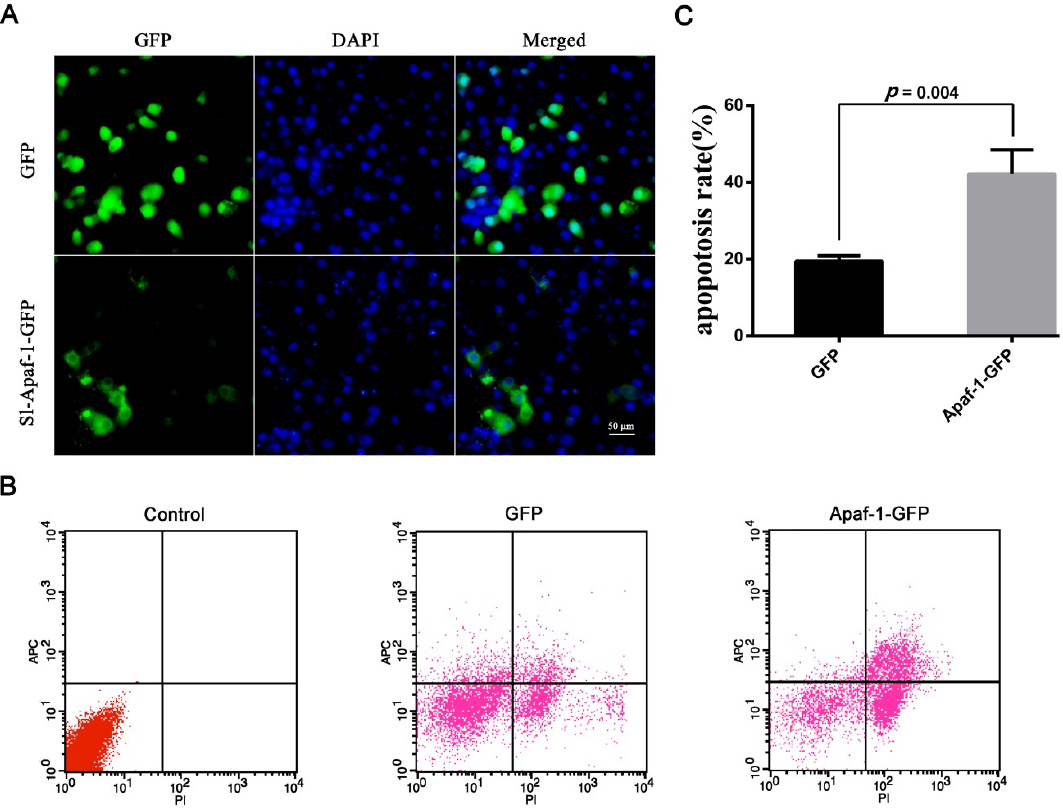
Figure 4. Sl-Apaf-1 overexpression in the SL-1 cell line. ( A ) Microscopic analysis of Apaf-1-GFP expression in SL-1 cells; ( B ) FACS analysis of SL-1 cells transfected with Apaf-1 overexpression vector, Left: Normal SL-1 cells; Middle: SL-1 cells transfected with GFP expression vector; Right: SL-1 cells transfected with the Sl-Apaf-1-GFP fusion expression vector; ( C ) Act-D-induced apoptosis of SL-1 cells when Sl-Apaf-1 was overexpressed.